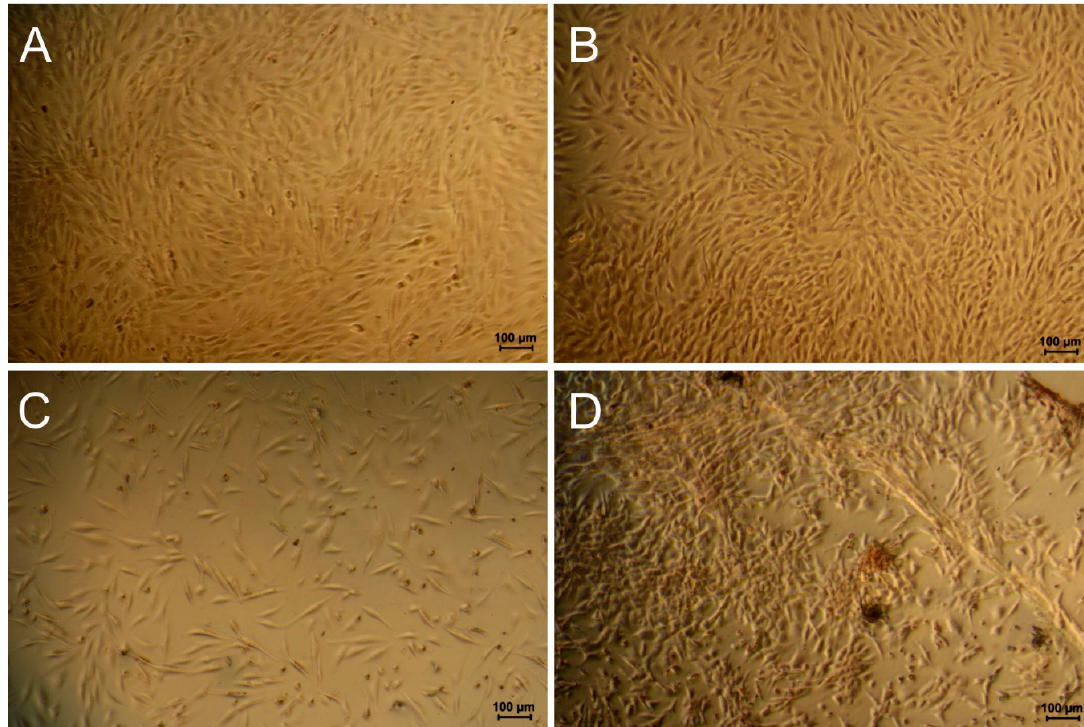
Figure 2. Light microscopy images of Alizarin red stained MG63 cells. ( A ) Cells grown on Reference substrate, ( B ) LbL, ( C ) FeDip10, and ( D ) FeDip50 at day 3.